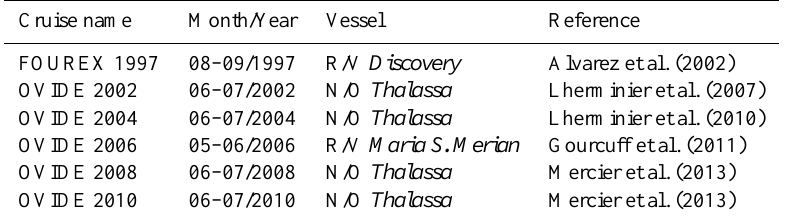
Table 2. Hydrographic